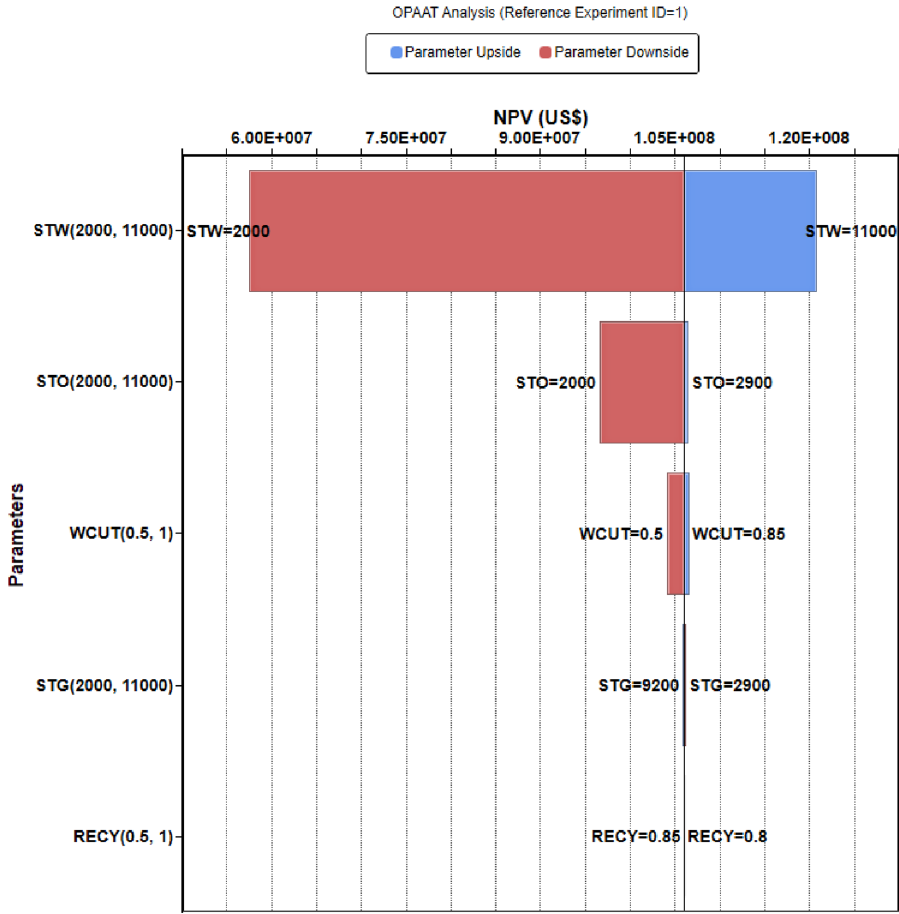
Fig. 10 Sensitivity analysis of the parameters used in this